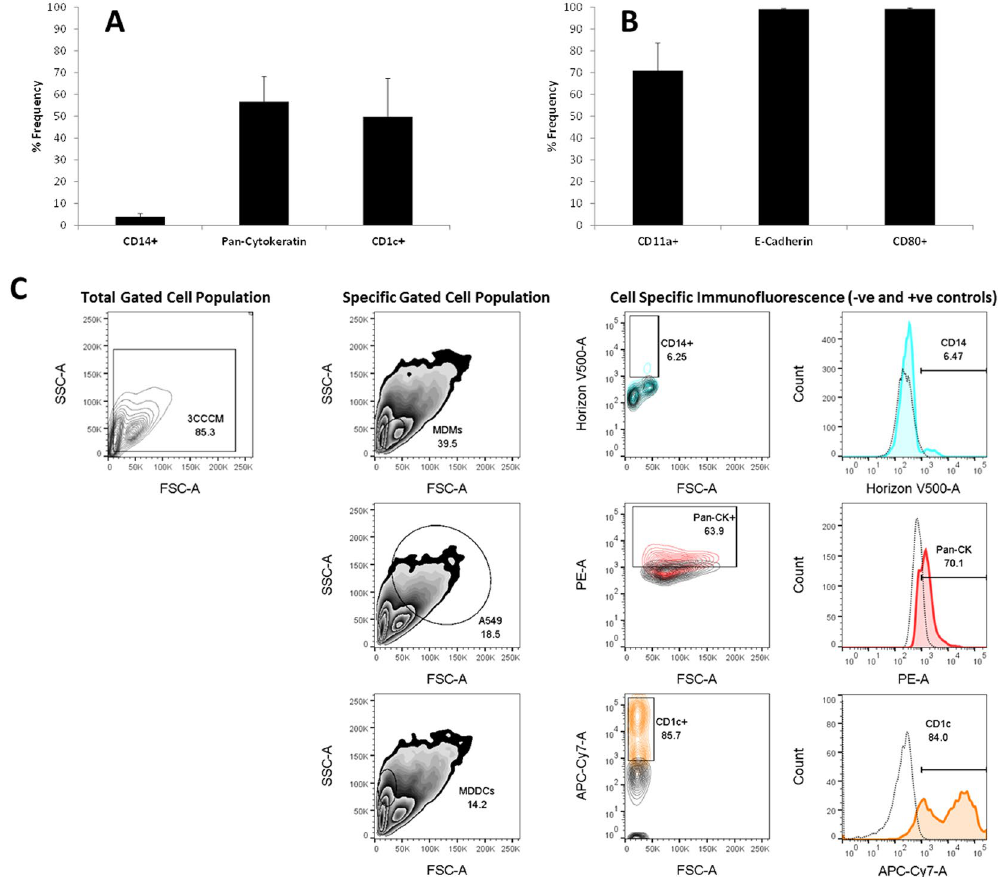
Figure 4. Percentage frequency (%Frequency) of specific surface marker expression upon human blood monocyte derived macrophages (MDM) and dendritic cells (MDDC), as well as A549 epithelial cells when present in the multi-cell model suspension culture. In ( A ) CD14, Pan-Cytokeratin (A549 epithelial cells) and CD1c and ( B ) CD11a (MDM), E-Cadherin (A549 epithelial cells), CD80 (MDDC) show the average %Frequency for the antibody master-mix used (please refer to SI Table 1 for all antibody information). Data was obtained after implementing the specific gating strategy for the co-culture suspension (SI Fig. 1B) ( C ). Samples were analysed via three-colour flow cytometry (FACS). All data was analysed using FlowJo (Version 10, TreeStar, USA). In ( A and B ) all data expressed is the mean ± standard error of the mean (SEM) of the %Frequency. Experimentation was repeated on three separate occasions in triplicate (n =